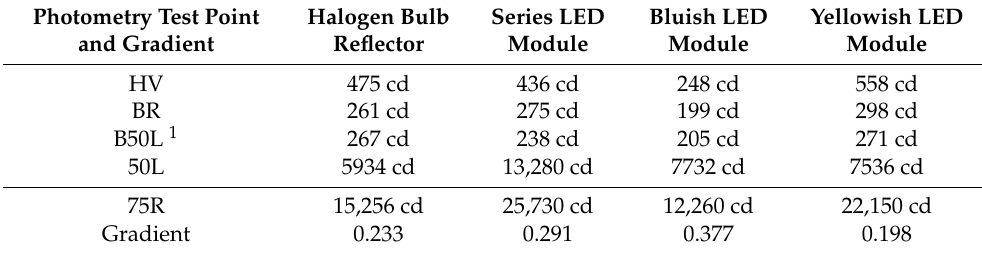
Table 3. Right light samples and their main photometric values as per ECE standards. Photometry Test Point and Gradient